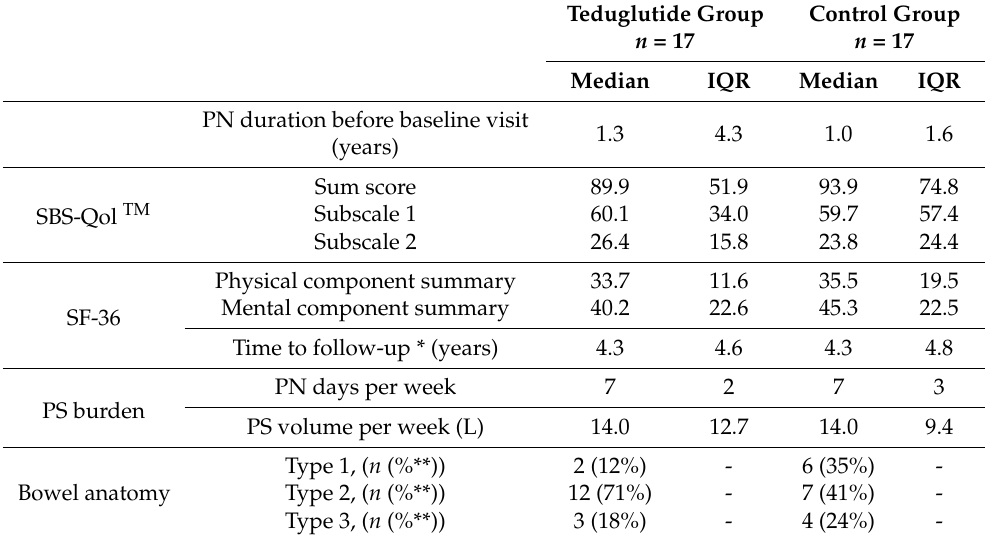
Table 2. Matching characteristics (ranked order).